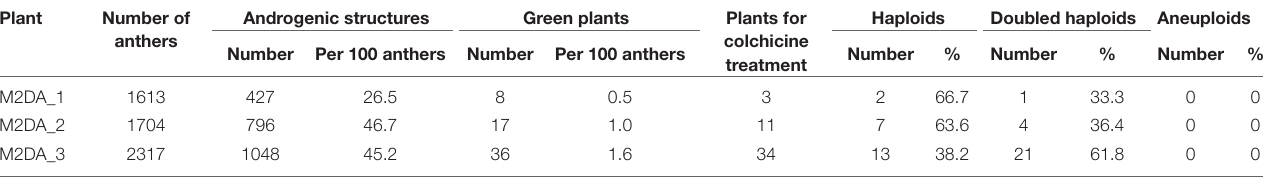
TABLE 3 | Characterization of androgenesis induction and doubled haploid production from three monosomic 2D addition plant of triticale. Plant DH lines Total number Chromosome Number of Number of Number of Number of analyzed constitution lines spikes seeds